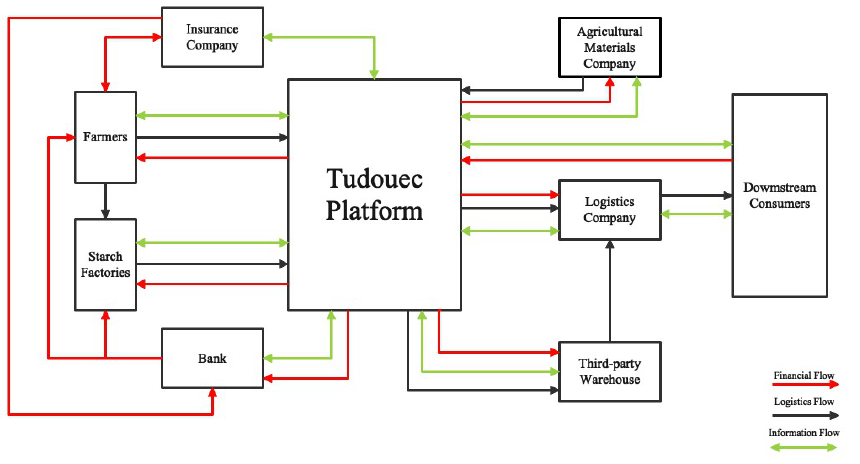
Figure 3. Supply chain model of